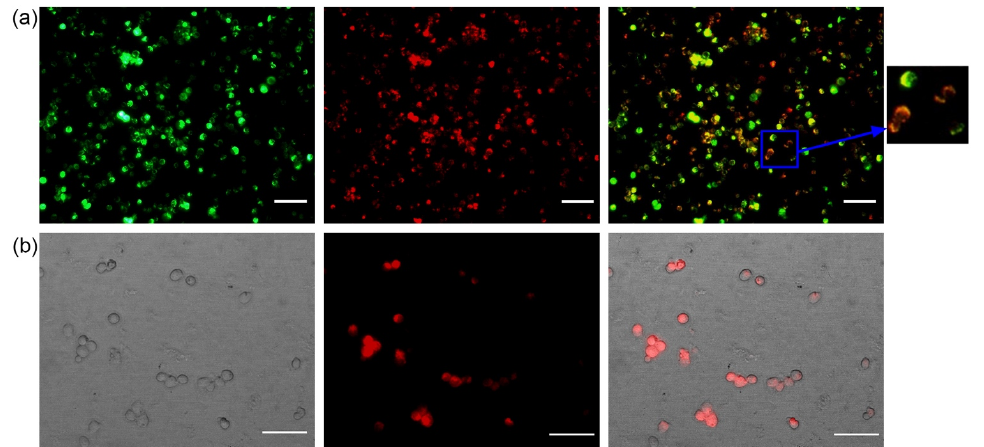
Figure 1. Microscopic analysis of target cells following mitochondrial transfer. ( a ) Representative images of mitochondrial transplantation between macrophages co-stained with fluorescent mitochondrial dyes (MitoTracker Green and MitoTracker Red CMXRos). Green: endogenous mitochondria of recipient cells, red: transferred mitochondria isolated from macrophages, yellow: merged mitochondria. Scale bar 50 μ m (magnification ×20). ( b ) Fluorescence microscopy of recipient cells after mitochondrial transfer. The last image on the right corresponds to the merge image of staining exogenous mitochondrial versus visible microscopy. Scale bar 50 μ m (magnification ×40). Representative pictures of six independent experiments are shown. Cells were viewed on a Leica TCS NT laser microscope.